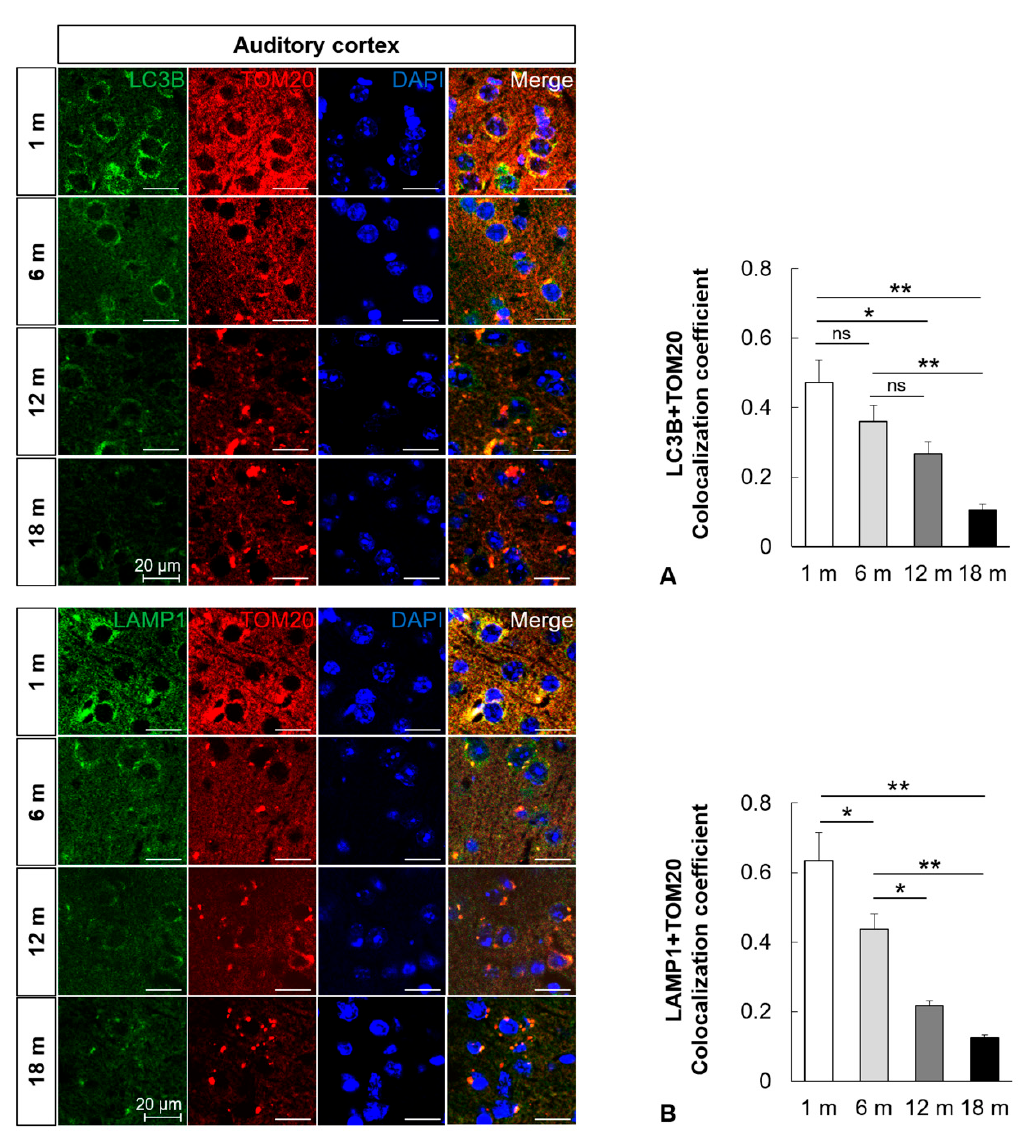
Figure 3. Impairment of mitophagy in the mouse auditory cortex with aging. ( A ) Colocalization analysis of autophagosomes and mitochondria. Immunofluorescence analysis revealed that the colocalization (yellow puncta, the overlap color) of LC3B (green) and TOM20 (red) in the mouse auditory cortex significantly decreased with aging. ( B ) Colocalization analysis of lysosomes and mitophagosomes. Immunofluorescence analysis revealed that the colocalization (yellow puncta, the overlap color) of LAMP1 (green) and TOM20 (red) in the mouse auditory cortex significantly decreased with aging. The data are shown as mean ± standard error of mean (five mice per group; 1 m, 1 month; 6 m, 6 months; 12 m, 12 months; 18 m, 18 months; DAPI, 4 ′ ,6-diamidino-2-phenylindole). * p < 0.05, ** p < 0.01, ns: not significant.